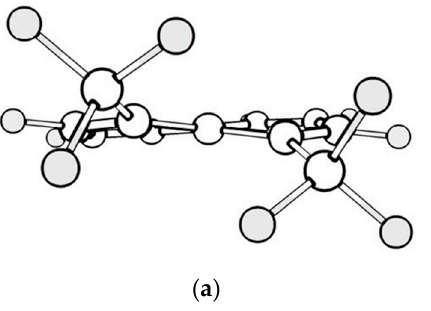
Figure 5. Deformation of aromatic ring in molecules 1 ‐ 45 ( a ) and 1 ‐ 457 ( b ) (X = H). Structure 2 ‐ 45 is similar in this case to 1 ‐ 45.